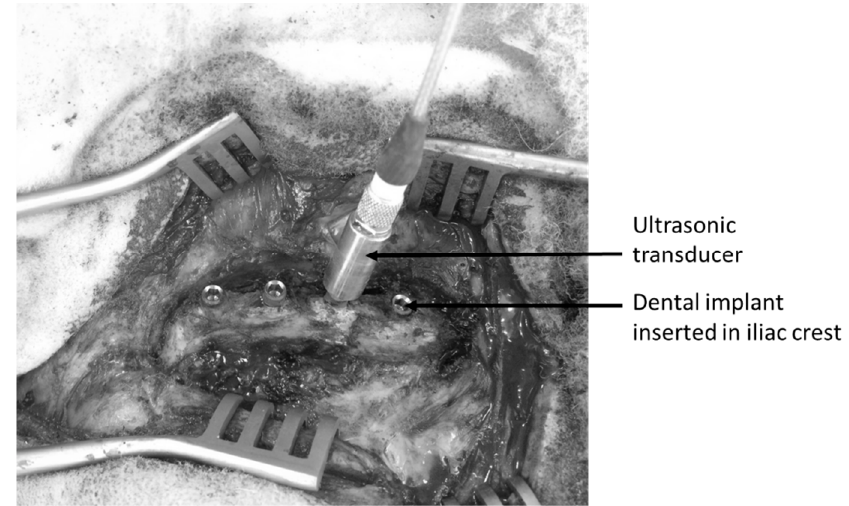
Figure 3. Measurement configuration of the ultrasonic indicator using the ultrasonic transducer screwed into a dental implant.